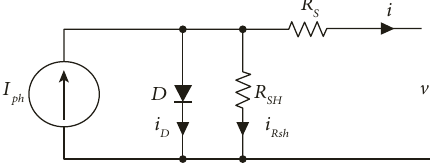
Figure 2: Electrical circuit of the PV